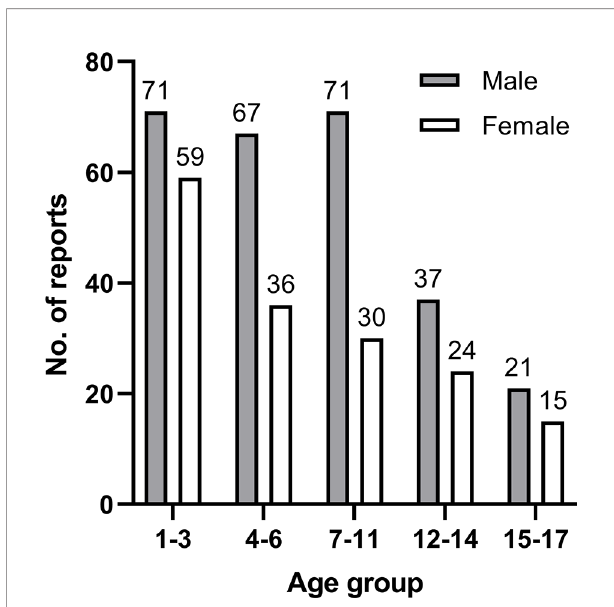
FIGURE 1 | Number of reports in each age group by